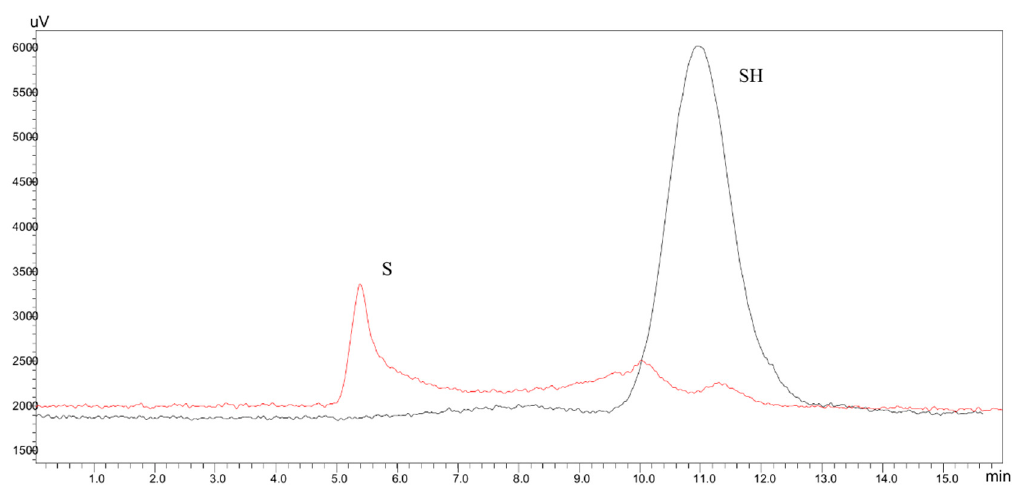
Figure 2. SEC-HPLC chromatograms of the soluble fraction of DL (S) and its hydrolysis products (SH).